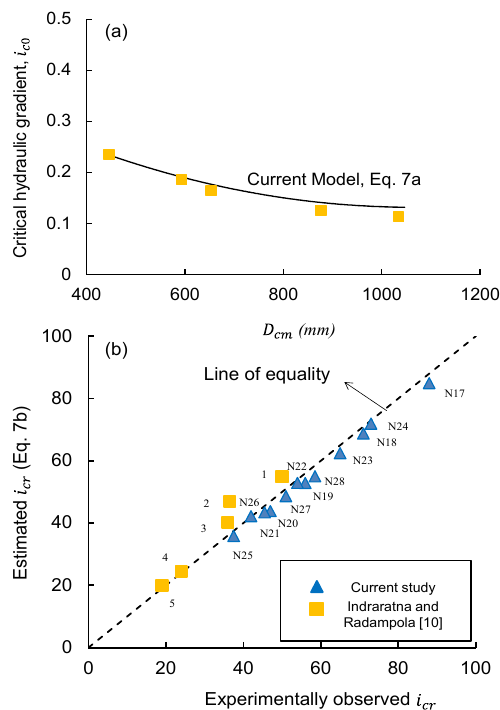
Figure 6. ( a ) Plot of hydraulic gradient for unit displacement of base particle i c 0 observed [10] and that estimated by Equation (7) versus mean constriction size D cm values, and ( b ) comparison between experimentally observed and theoretically estimated i cr data for the complete erosion of base soil through filter.